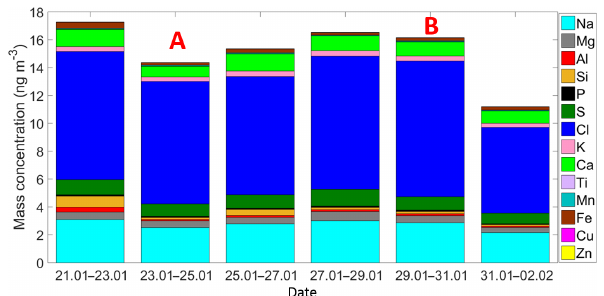
Figure 3. Time series of the ambient aerosol mass concentration and bulk chemical composition as measured by the XRF. Each sample was collected for 48h starting at 12:00h local time. A and B indi- cate that those samples were partially influenced by the passage of the cold front A and the cold front B,